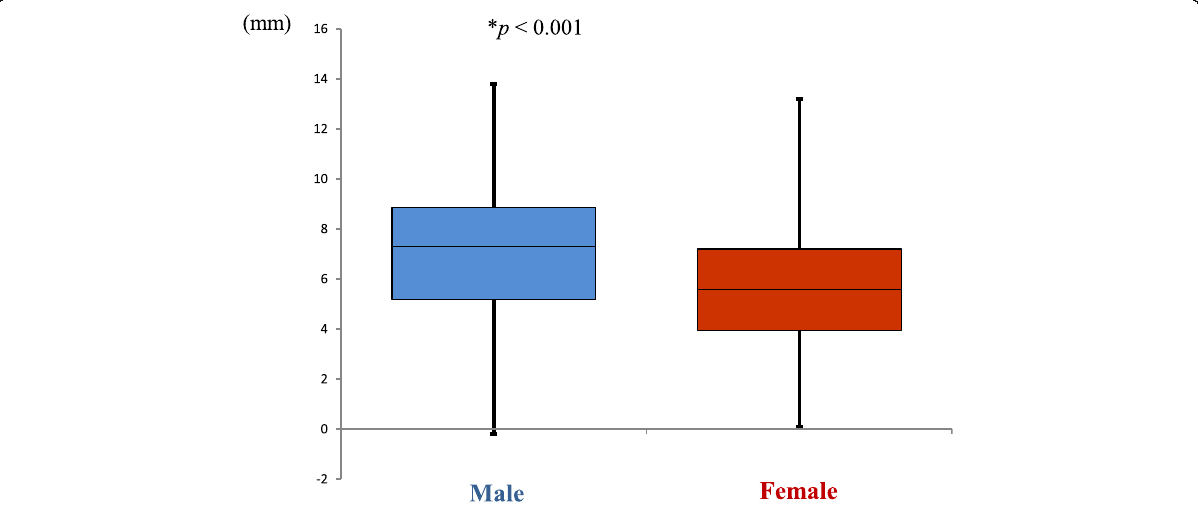
Fig. 4 Differences in phalangeal length (ring finger – index finger) in men and